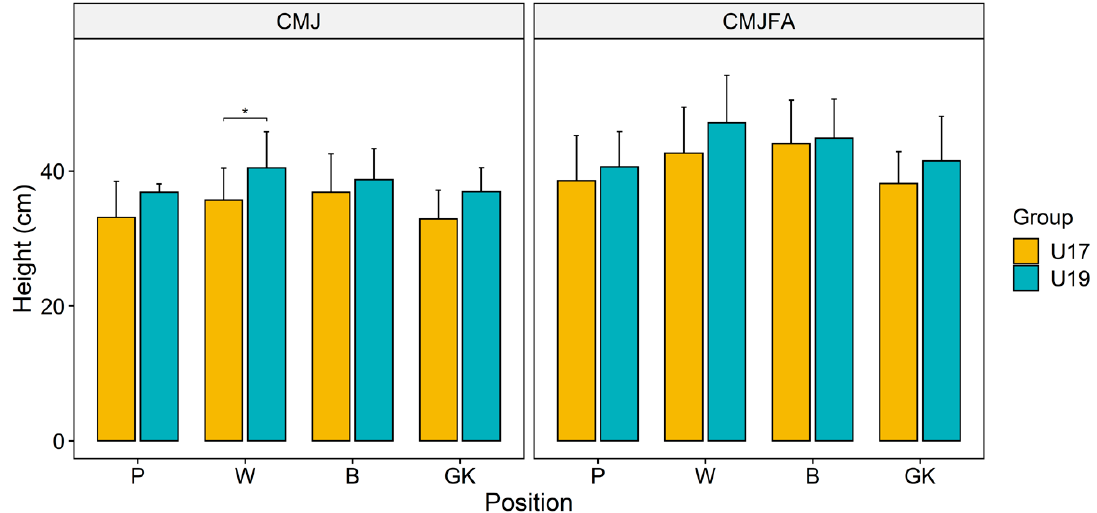
Figure 1. Test results of counter movement jump (CMJ) and counter movement jump free arms (CMJFA) of the participants. (P—pivots; W—wingers; B—backs; GK—goalkeepers; * p < 0.05).